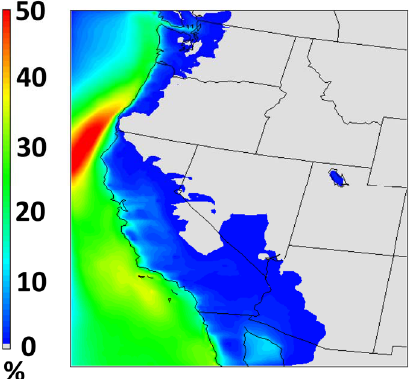
Fig. 3. Average percentage contribution of marine organics to sur- face OC 2 . 5 concentration for the bottom-up simulation from 1 June to 31 August 2005.